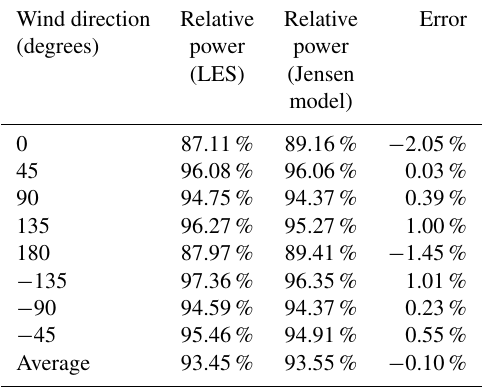
Figure 9. Optimal layout and relative power for the uniform wind- direction case (angle of ± 180 ◦ ). Relative power results are obtained from large-eddy simulations. Turbine locations are marked with coloured disk: size and colour scale by relative power. Plot bound- ary (red box) corresponds to boundaries of domain (cid:127) (see Fig. 1). Table 8. Uniform 360 ◦ case – evaluation of optimal layout. Relative power for eight different wind directions, comparing outputs of LES and Jensen wake model with k w =